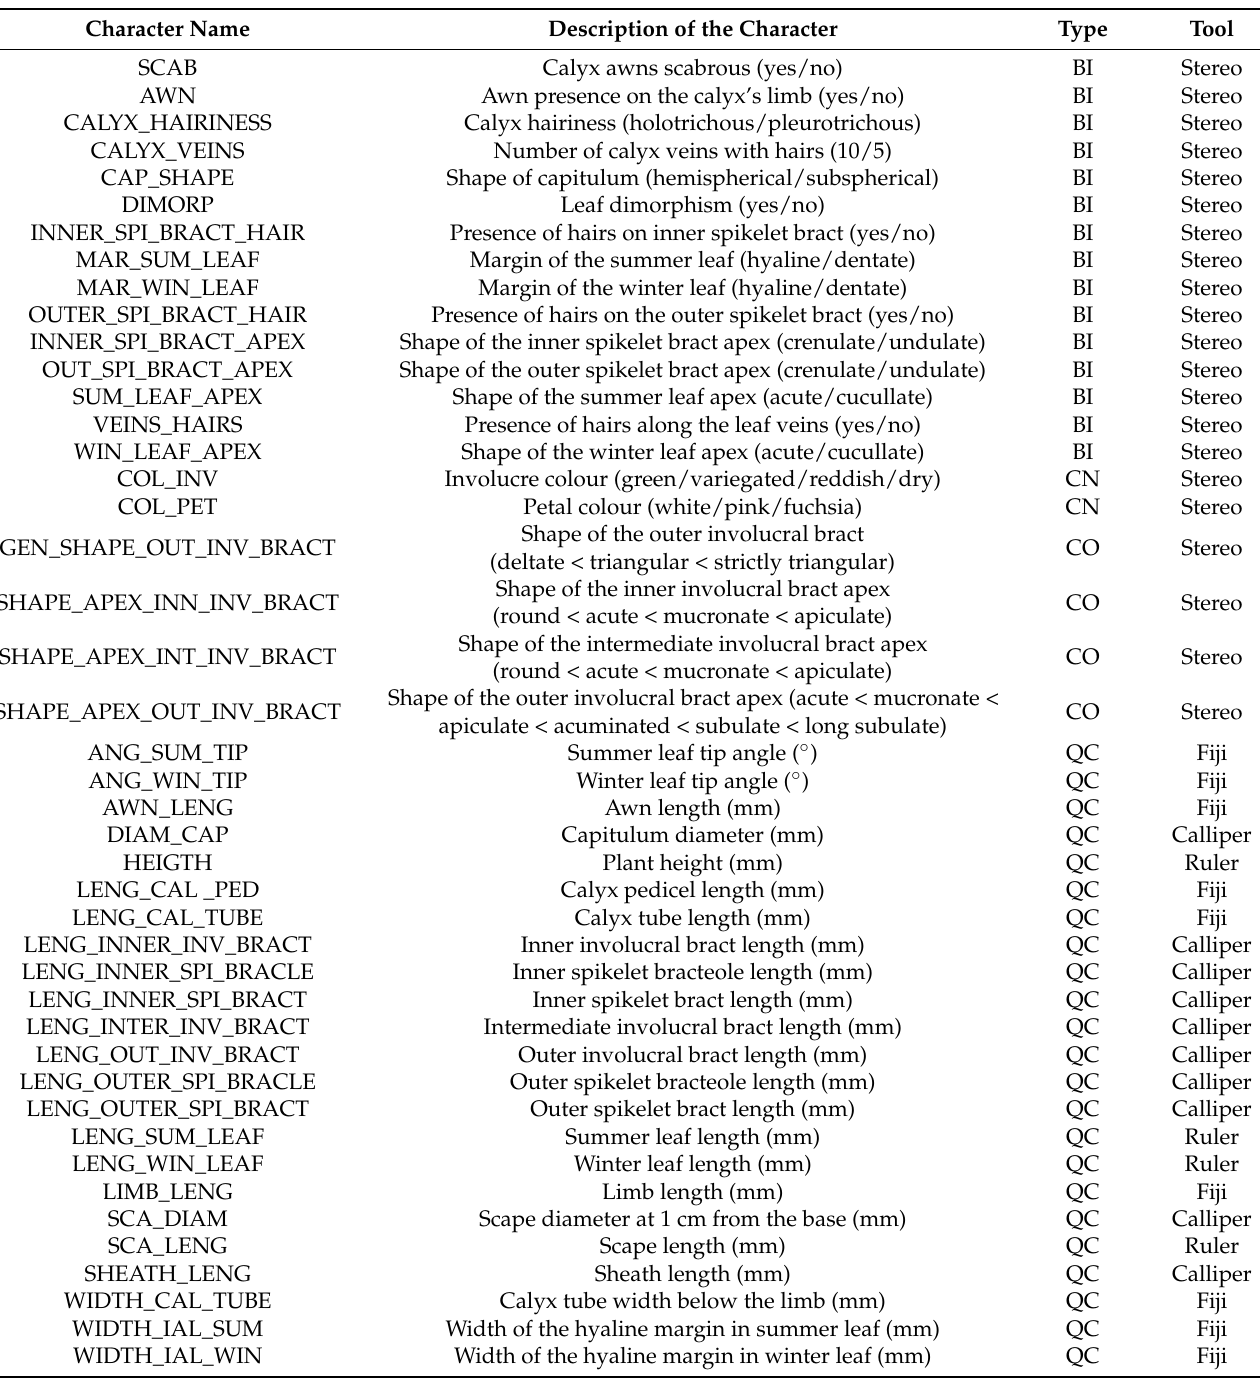
Table 2. Morphological characters studied in Armeria arenaria . QC = quantitative continuous, QD = quantitative discrete, CN = nominal, BI = binary, CO = ordered